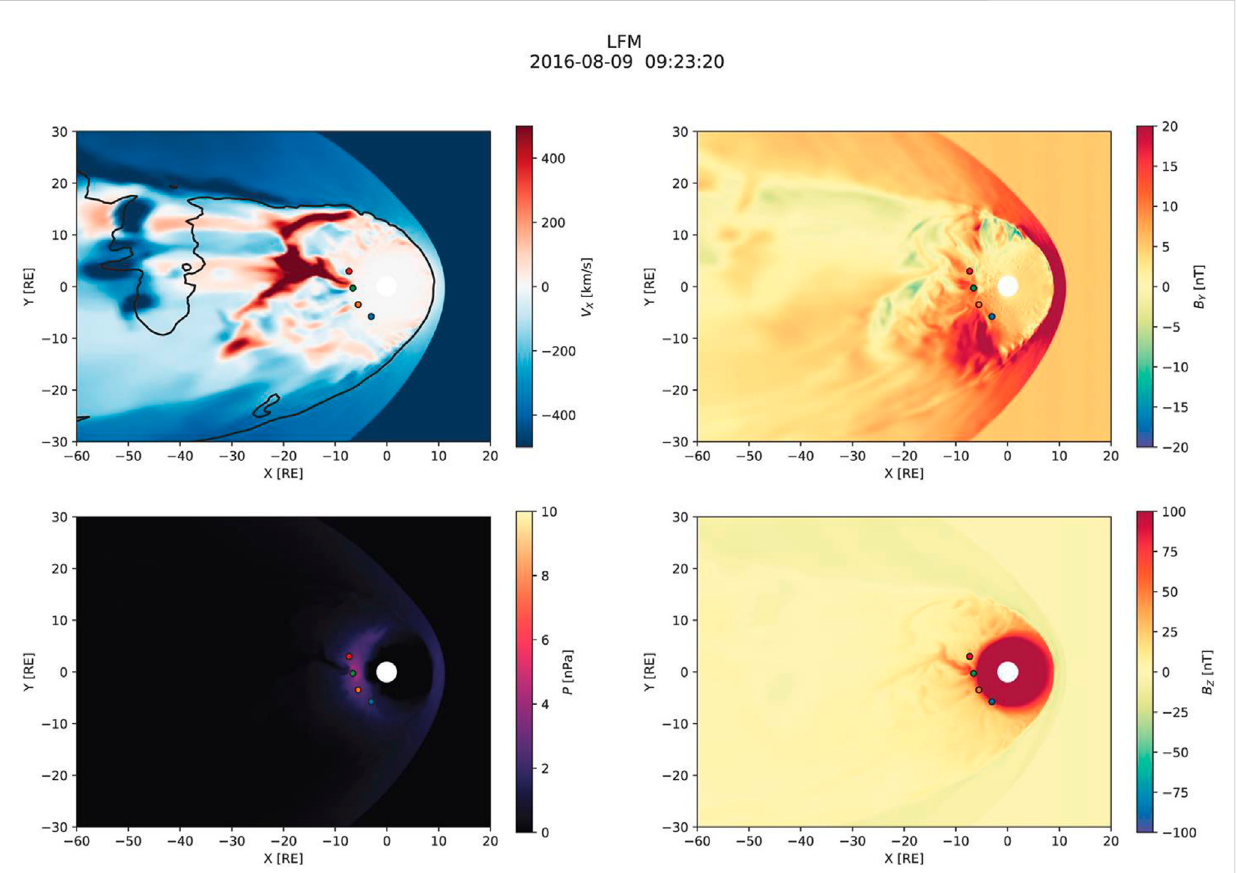
FIGURE 3 FromMerkinetal.(2019).Overviewofthesimulationaroundthetimeofsubstormonset.Thesolarmagneticequatorialplaneisshownineachpanel. Magnetospheric spacecraft are marked with blue (GOES-13), orange (GOES-14), green (GOES-15), and red (MMS-1) circles which indicate the spacecraft positions projected to the plane. The black contour in the upper left panel indicates the Bz = 0 isocontour. Note bottom right shows a mesoscale DFB impinging on the inner magnetosphere as the narrow red fi nger around X = − 10, Y = 0. In the upper left, the red fi nger at the same location shows earthward plasma fl ow up to 400